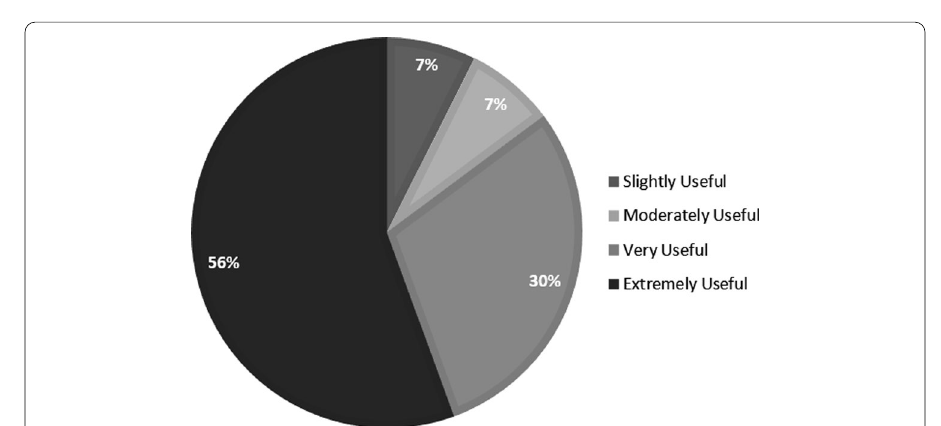
Fig. 2 Percentage of students providing different ratings of usefulness for captions and transcripts. No students felt that these were not at all